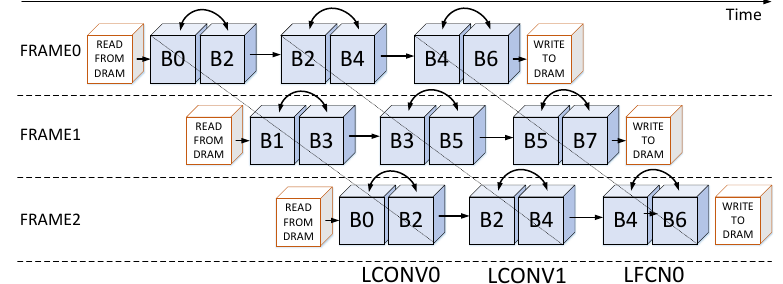
Figure 10. Interleaving banking scheduling